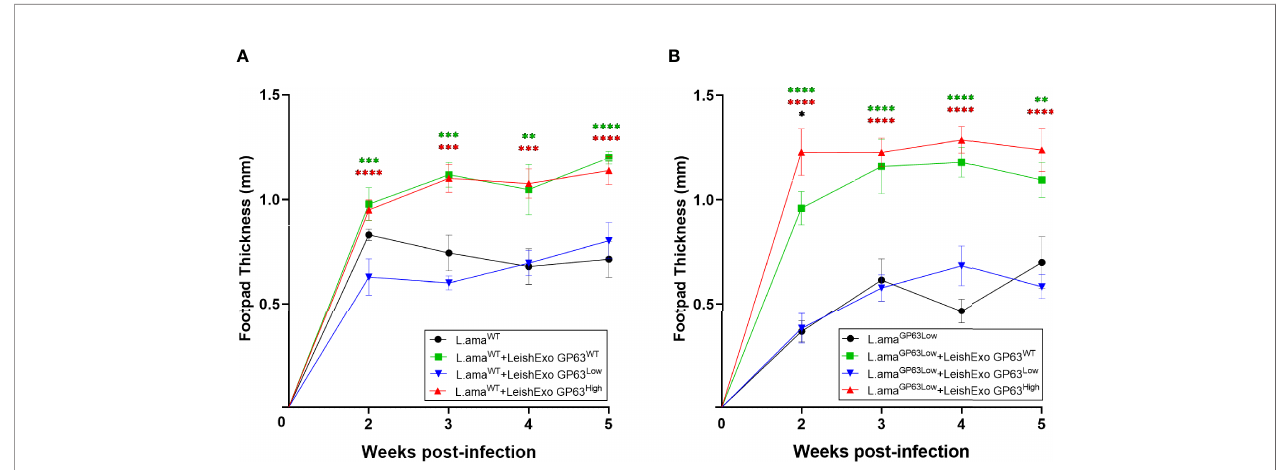
FIGURE 6 | Impact of various Leishmania amazonensis- derived EVs on Leishmania amazonensis infection. (A) In-vivo infection model using males Balb/c mice infected on their footpads with Leishmania amazonensis wild-type strain co-inoculated with EVs derived from either Leishmania amazonensis GP63 WT , GP63 Low, or GP63 High . ✱ = L.ama WT vs L.ama WT +LeishEXO GP63 WT ; ✱ = L.ama WT vs L.ama WT +LeishEXO GP63 High ; ✱ = L.ama WT vs L.ama WT +LeishEXO GP63 Low ; L.ama WT = Leishmania amazonensis GP63 WT . (B) In-vivo infection model using males Balb/c mice infected on their footpads with Leishmania amazonensis GP63 Low strain co- inoculated with EVs derived from either Leishmania amazonensis GP63 WT , GP63 Low or GP63 High ; ✱ = L.ama GP63Low vs L.ama GP63Low +LeishEXO GP63 WT ; ✱ = L.ama GP63Low vs L.ama GP63Low +LeishEXO GP63 High ; ✱ = L.ama GP63Low vs L.ama GP63Low +LeishEXO GP63 Low ; ✱ = L.ama GP63Low +LeishEXO GP63 WT vs L.ama GP63Low +LeishEXO GP63 High L.ama GP63Low = Leishmania amazonensis GP63 Low . 2-way ANOVA with multiple comparisons by uncorrected Fisher LSD`s Test; n=6; *p < 0.05; **p < 0.01; ***p < 0.001; ****p < 0.0001; Error bars = SEM; No symbol, non-signi fi